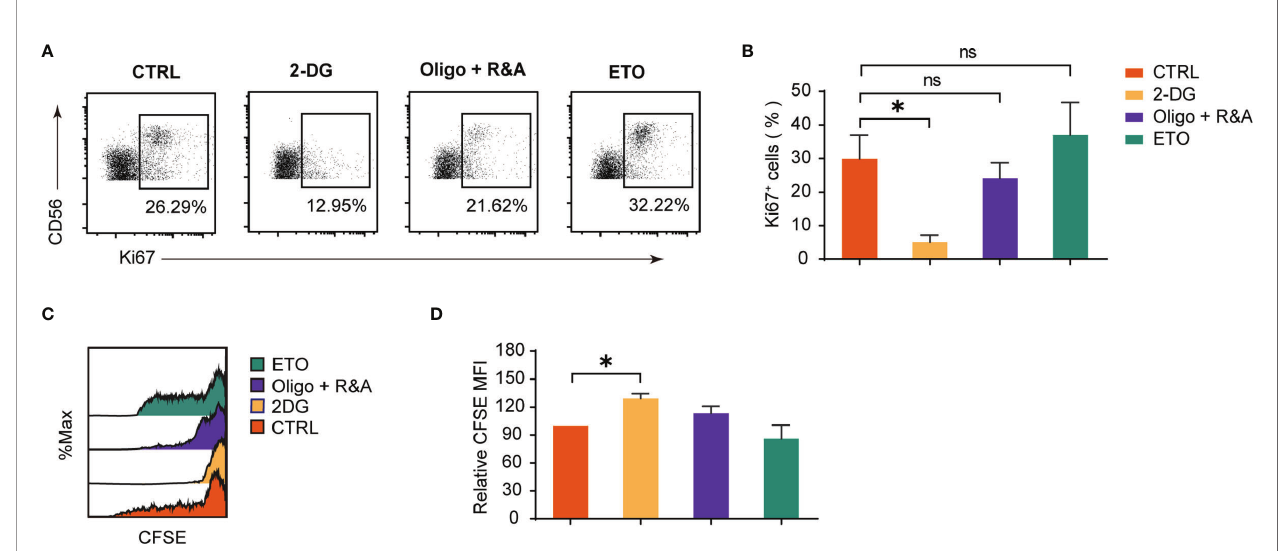
FIGURE 4 | Glycolysis underpins dNK proliferation. (A, B) Ki-67 staining on decidual immune cells (DICs) after treatment with various metabolism inhibitors for 48h. DICs were routinely cultured in full culture medium supplemented with 20 ng/ml IL-15. After treatment, Ki-67 positive dNK (CD3 - CD56 + cells) were analyzed by FCM (n = 5-6, paired t test). (C, D) Representative histogram shows CFSE dilution of dNK (CD3 - CD56 + cells). The summary graph shows the relative CFSE intensity of dNK (n = 5, One sample t-test). ns, not signi fi cant; * P <